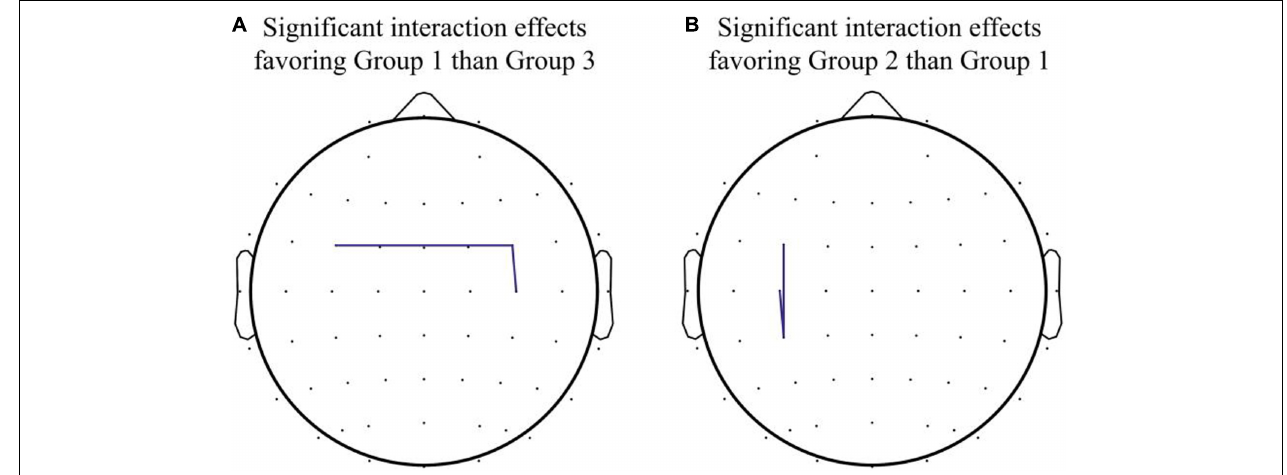
FIGURE 4 | Significant interaction effects in channel pairs. (A) Significant interaction effects favoring Group 1 over Group 3 were noted in coherence between FC3 and FC4 and between FC4 and C4. (B) Significant interaction effects favoring Group 2 over Group 1 were noted in coherence between FC3 and CP3 and between C3 and